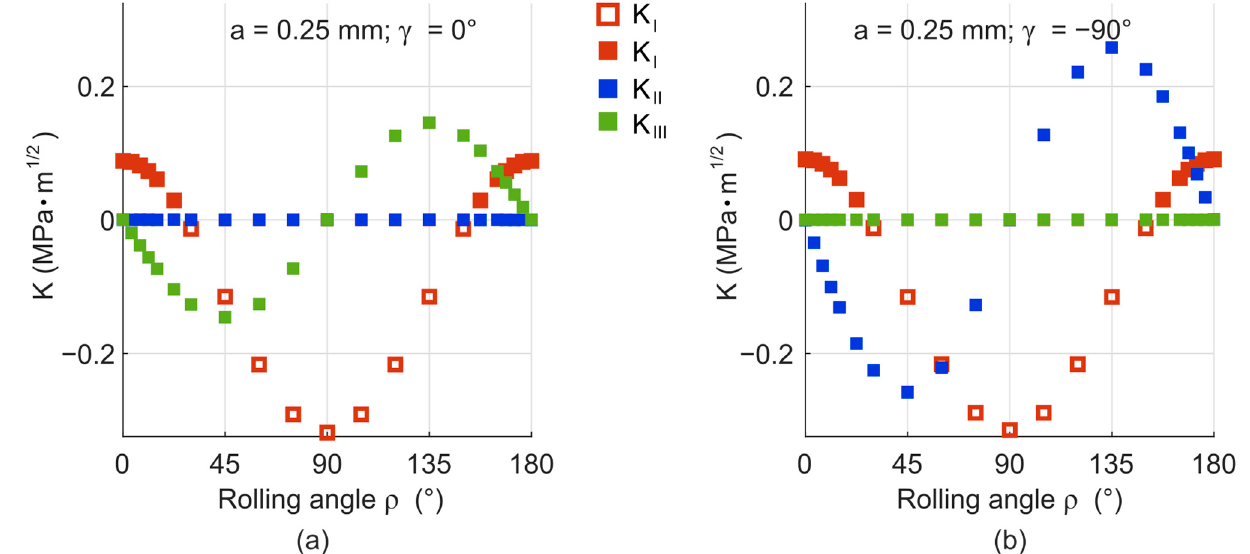
Figure A1. Course of stress intensity factors during rotation in the cylinder D × L = 6 × 6 mm, load F = 350 N, a = 0.25 mm, position on the crack front; ( a ) γ = 0°; ( b ) γ = − 90°.